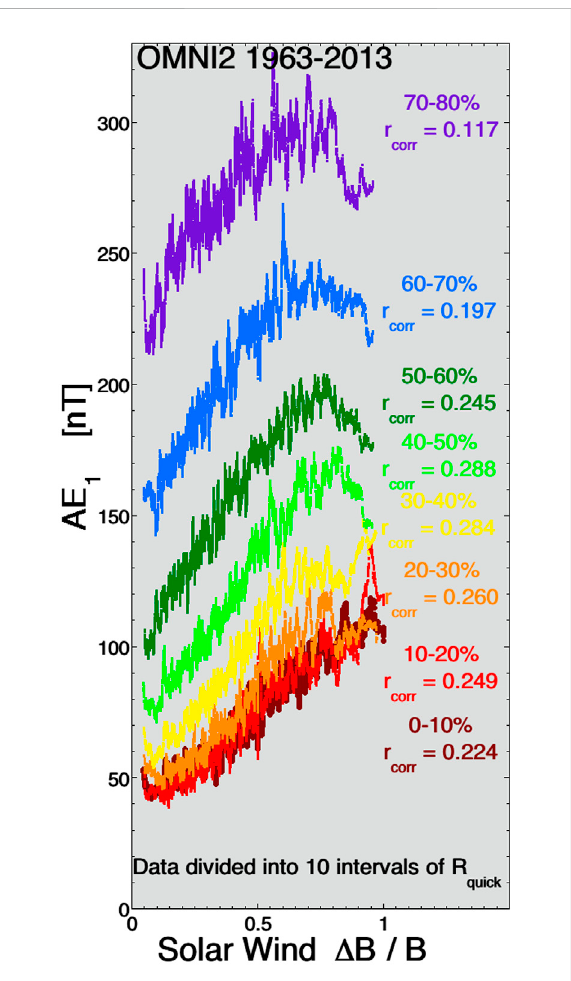
FIGURE 1 For times when the value of R quick is in 10-percent intervals, 300-point running averages of the one-hour-lagged AE index is plotted as a function of the amplitude Δ B/B of the upstream solar- wind